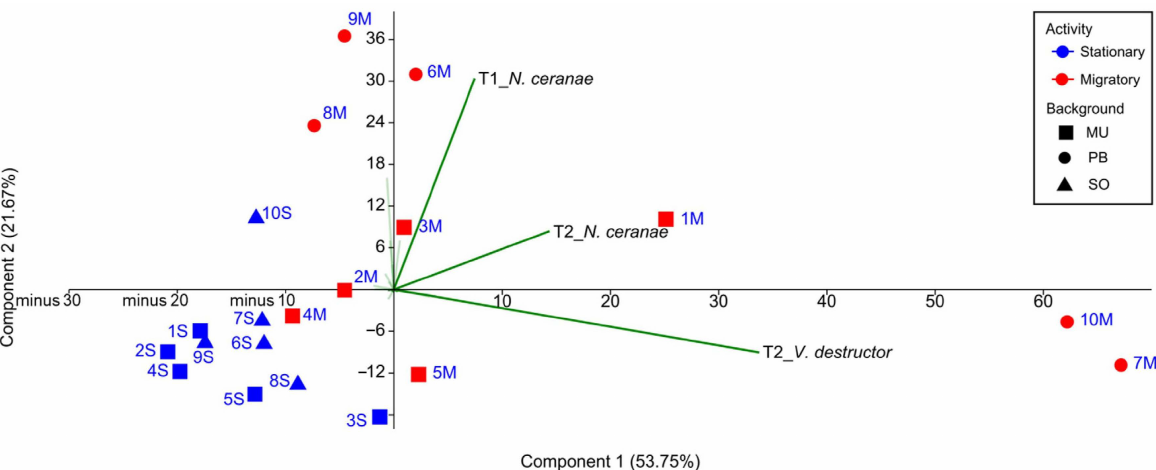
Figure 4. Scatterplot of the colonies showing dissimilar dispersion of stationary and migratory colonies according to the rates of parasitism. The code of the colonies has been abbreviated for better visualization (stationary in blue and migratory in red, squares for the University of Murcia (UM), circles for the professional beekeeper (PB) and triangles for Soria